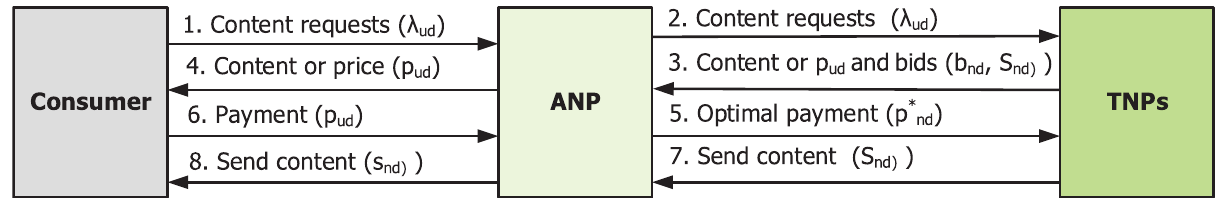
Fig 2. Auction workflow for congestion-aware